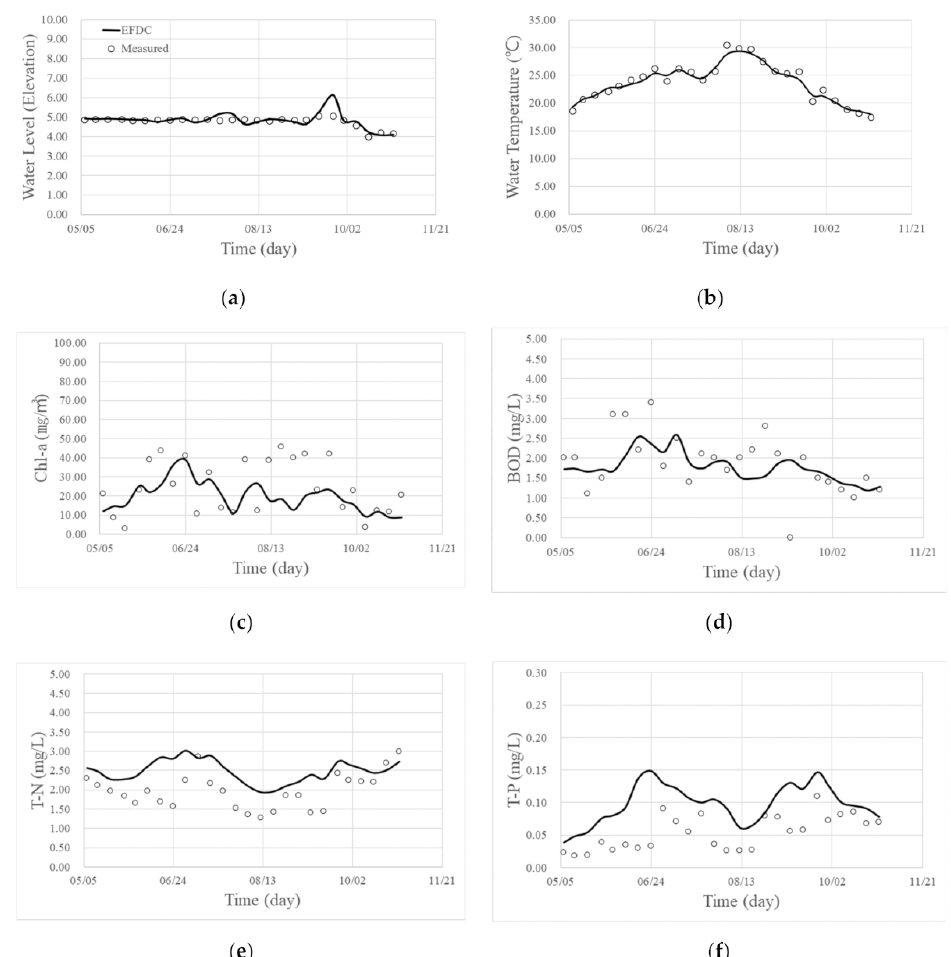
Figure 7. Comparison of simulated water quality results with those measured at a point 500 m up- stream from the Changnyeong-Haman Weir: ( a ) Water level; ( b ) Water temperature; ( c ) Chlorophyll-a; ( d ) BOD; ( e ) T-N; ( f ) T-P.